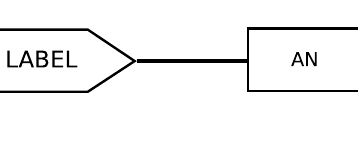
Figure 2.23: The Activity Flow glyph for Equivalence arc